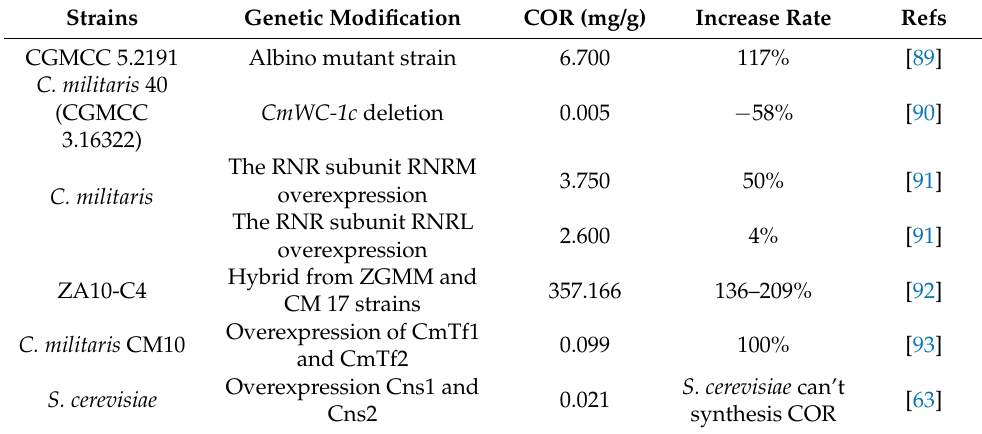
Table 5. COR contents in different genetic modified C. militaris